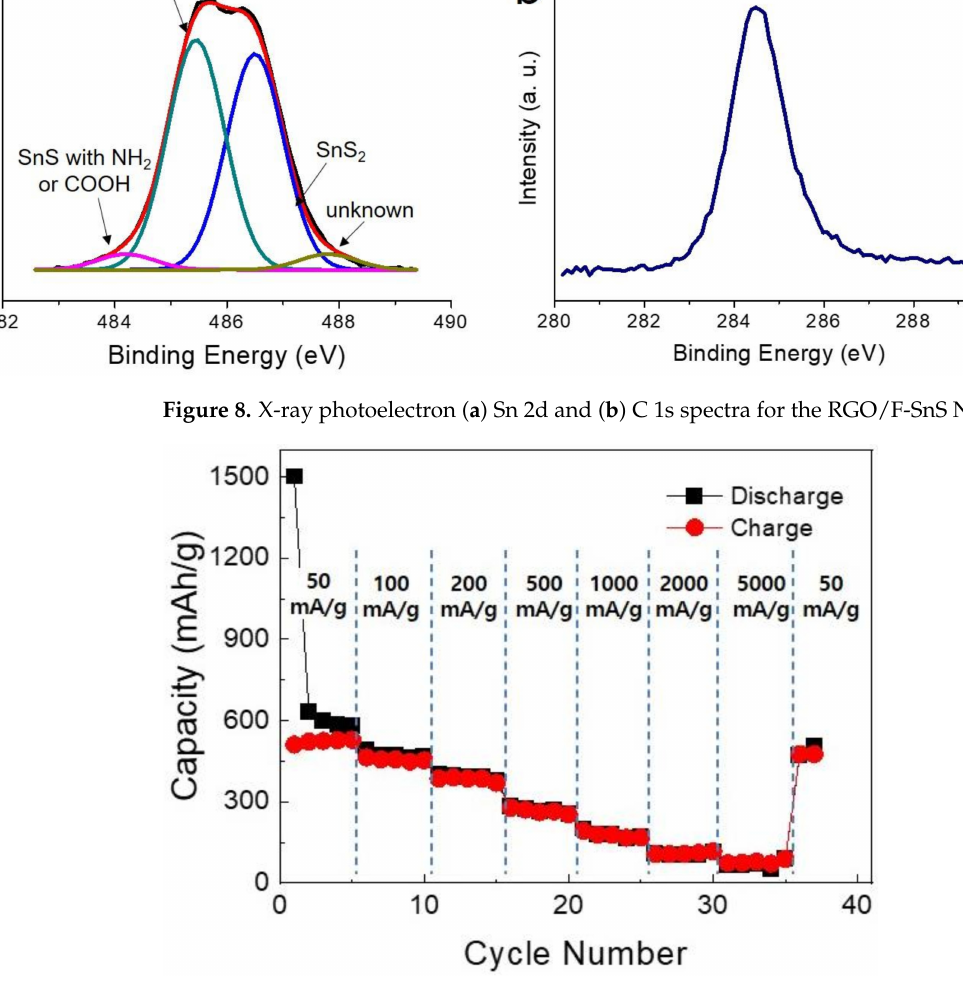
Figure 9. Rate capability at different current densities for the cell employing the RGO/F-SnS NCs active